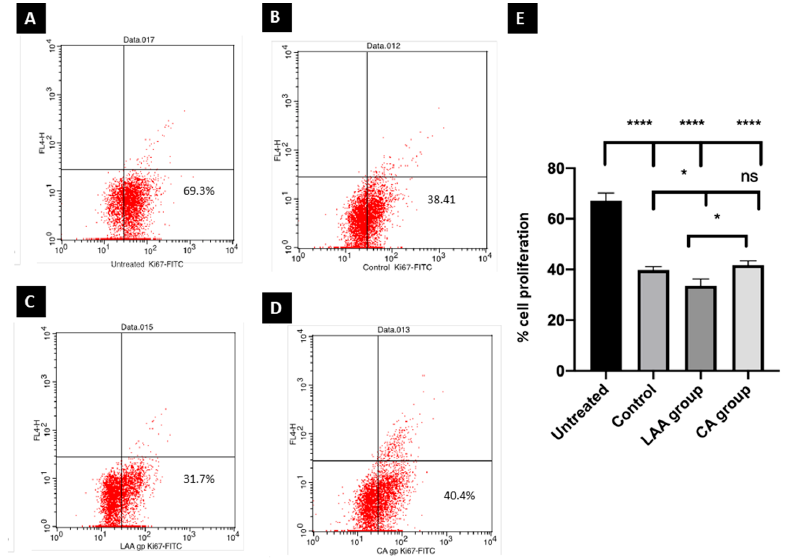
Figure 3. Ki-67 flow cytometry proliferation assay. Untreated ( A ); control ( B ); L-ascorbic acid ( C ); citric acid ( D ). Statistical analysis for the cell proliferation of different groups blotted on X axis and % of proliferation on Y axis, where proliferation of cells in all groups was significantly lower than